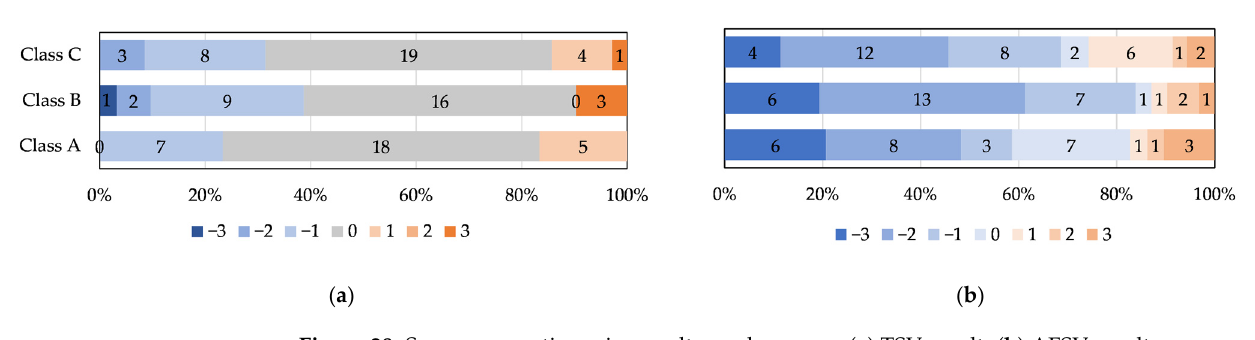
Figure 28. Summer questionnaire result per classroom. ( a ) TSV result. ( b ) AFSV result. Figure 29 shows the correlation between the field measurement result and TSV. The indoor thermal comfort range percentage (based on BESCS) and TSV correlation are shown in Figure 29a. Data on the indoor thermal comfort range percentage based on the BESCS are derived from the average data of the three classrooms on 4 September 2019, when the TSV questionnaire was distributed. The TSV data in this graph are the three classrooms averaged values calculated from the average of four seat positions TSV near each measurement point. It shows that point 8 (cid:13) has the smallest TSV value ( − 0.5) and is correlated to the thermal comfort range percentage based on the BESCS, which has the smallest comfort range percentage (47.6%).